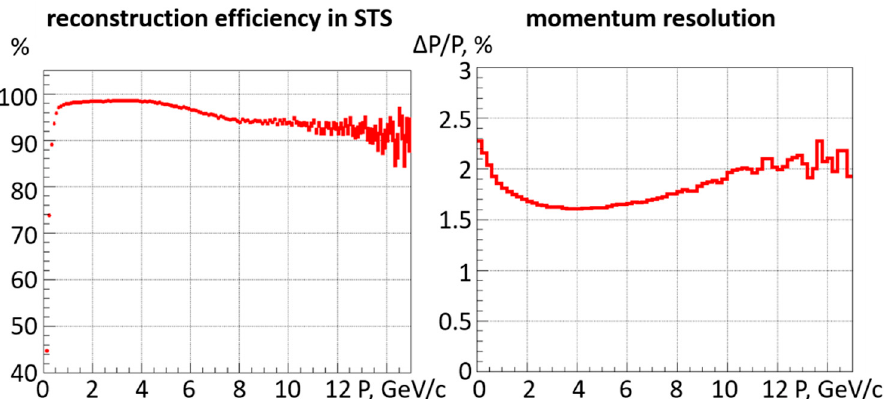
Figure 4. Reconstruction efficiency for charged particles in the STS ( left ) and the corresponding momentum resolution ( right ) for central Au + Au collisions at 8 A GeV/c.